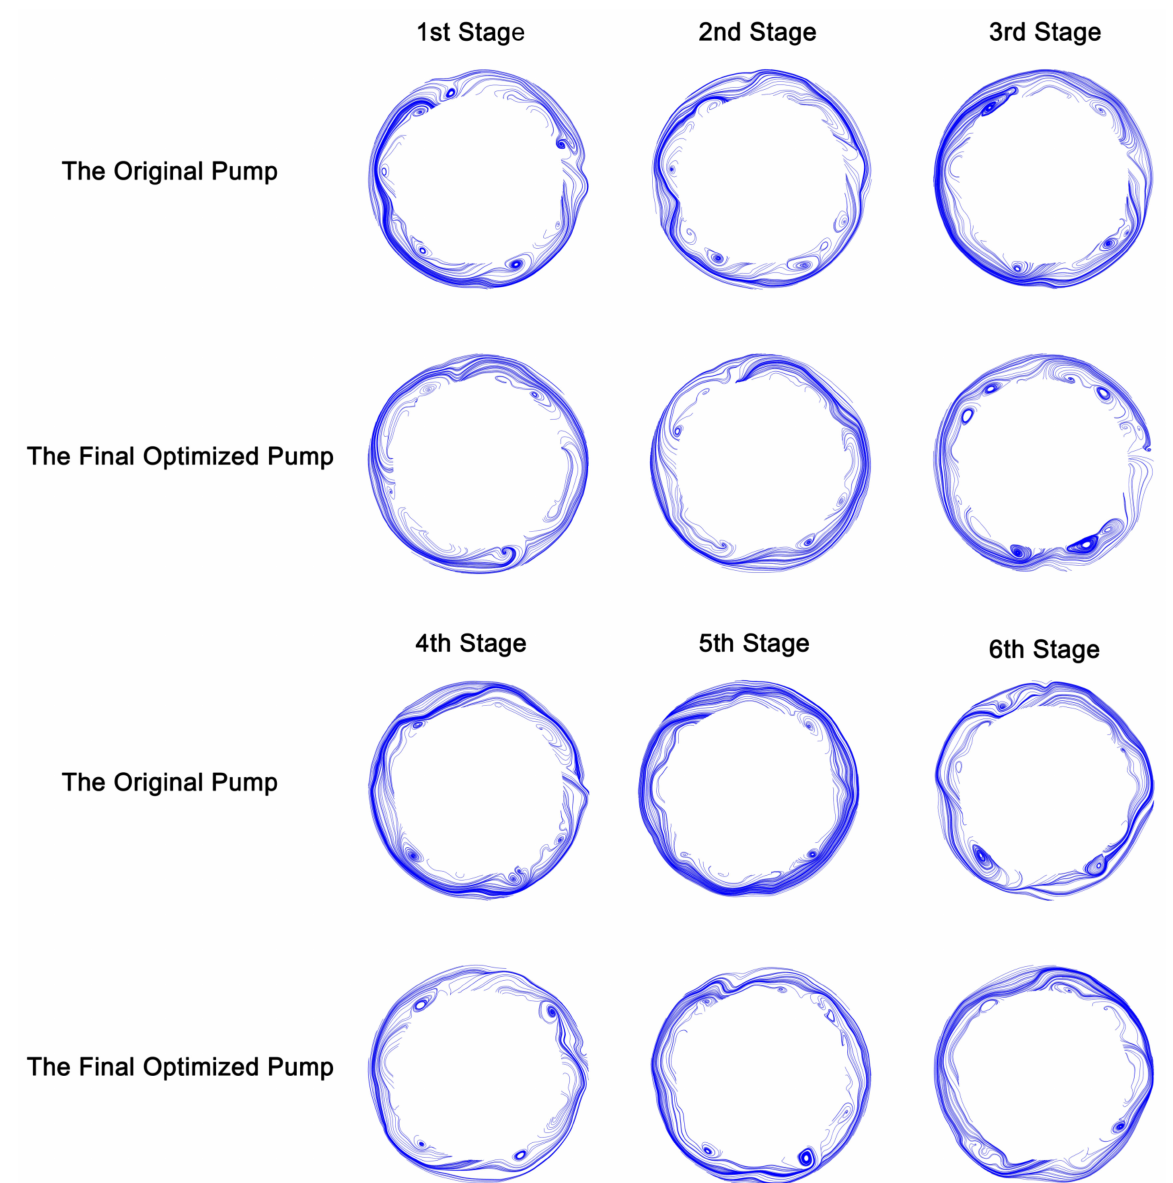
Figure 14. The streamlines on the cross-section at the transition between the impeller outlet and the diffuser